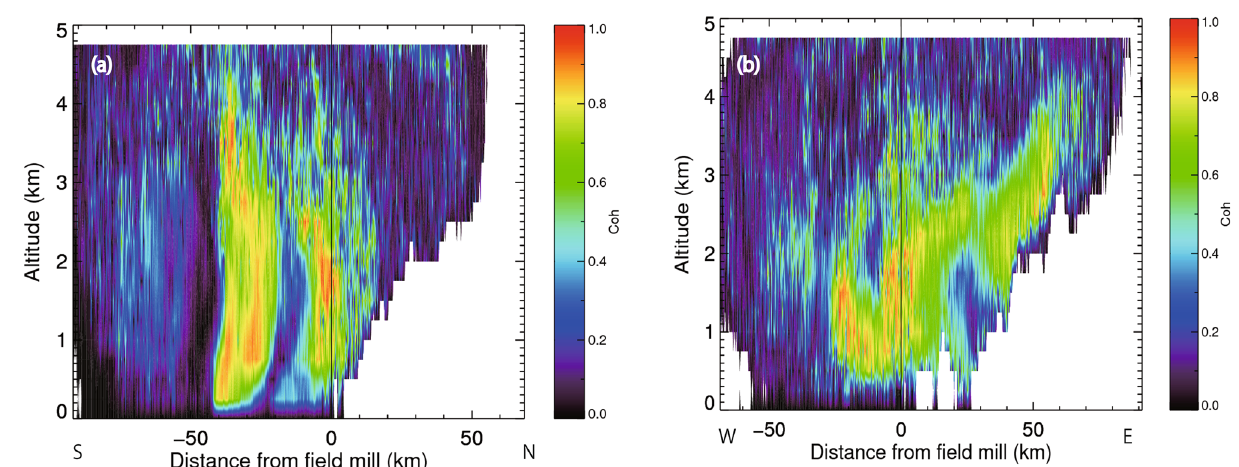
Figure 8. ( a ) Coherence of the main period between the atmospheric electric fields at CHB and radar reflectivity of the PAWR in the North–South direction, and ( b ) the same format but in the East–West direction centered at